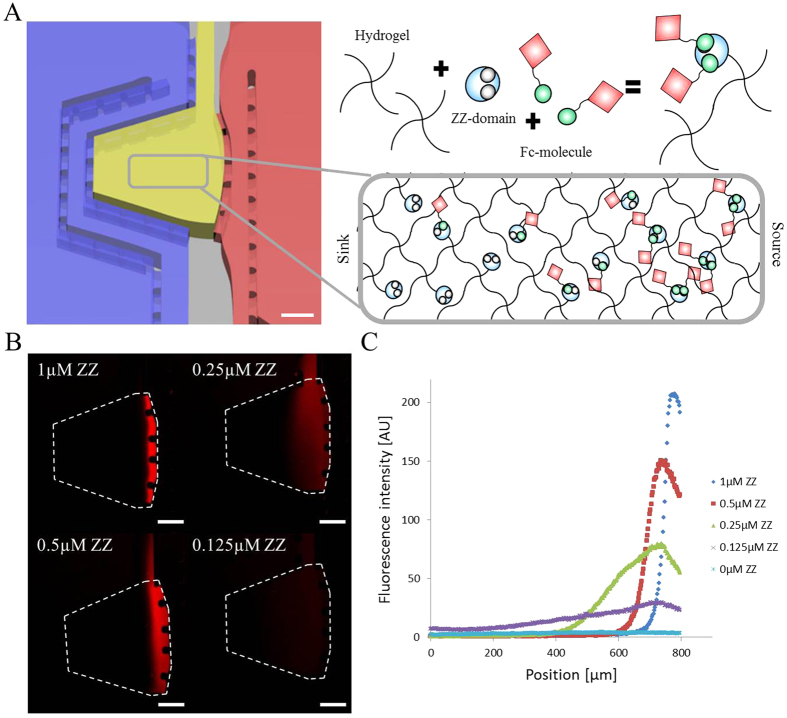
Generation of gradients of immobilized biomolecules via Fc–ZZ coupling and source–sink diffusion.(A) Schematic representation of the gradual functionalization of hydrogel compartment. Fc-tagged molecules diffused and became trapped in the hydrogel compartment that was pre-functionalized with the ZZ domain. (B) The gradient profile is determined by the concentration of incorporated ZZ domain. Sharper profiles are obtained with a high relative concentration of the ZZ domain. Gradients were visualized at day 1 with confocal microscopy. Scale bars indicate 200 μm. (C) Observations were confirmed with quantification. Values are displayed as the mean value over three replicates.